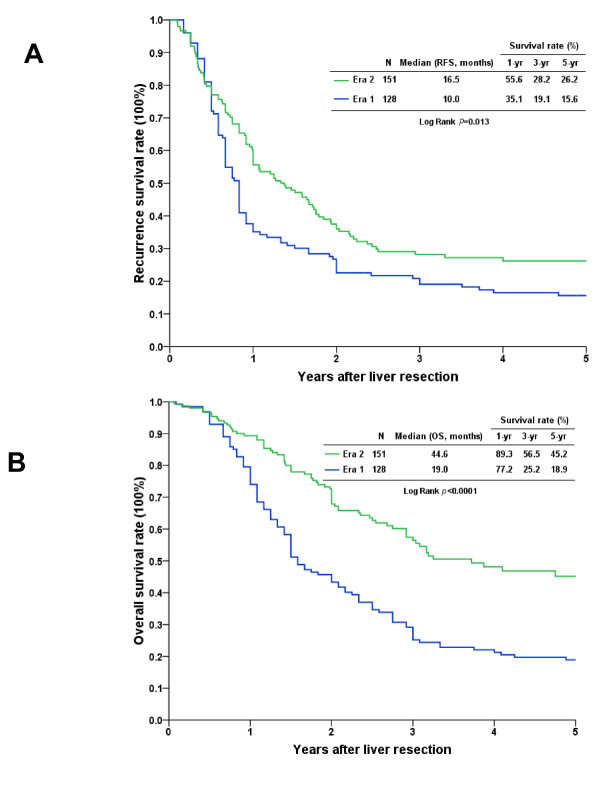
Cumulative survival curves of patients who underwent liver resection for hepatic metastasis according to the era of their treatment. A. The recurrence-free survival (RFS) rates in era 2 were significantly better than the RFS rates in era 1 (p = 0.013). B. The overall survival (OS) rate in era 2 was better than the OS rate in era 1 (p < 0.0001).